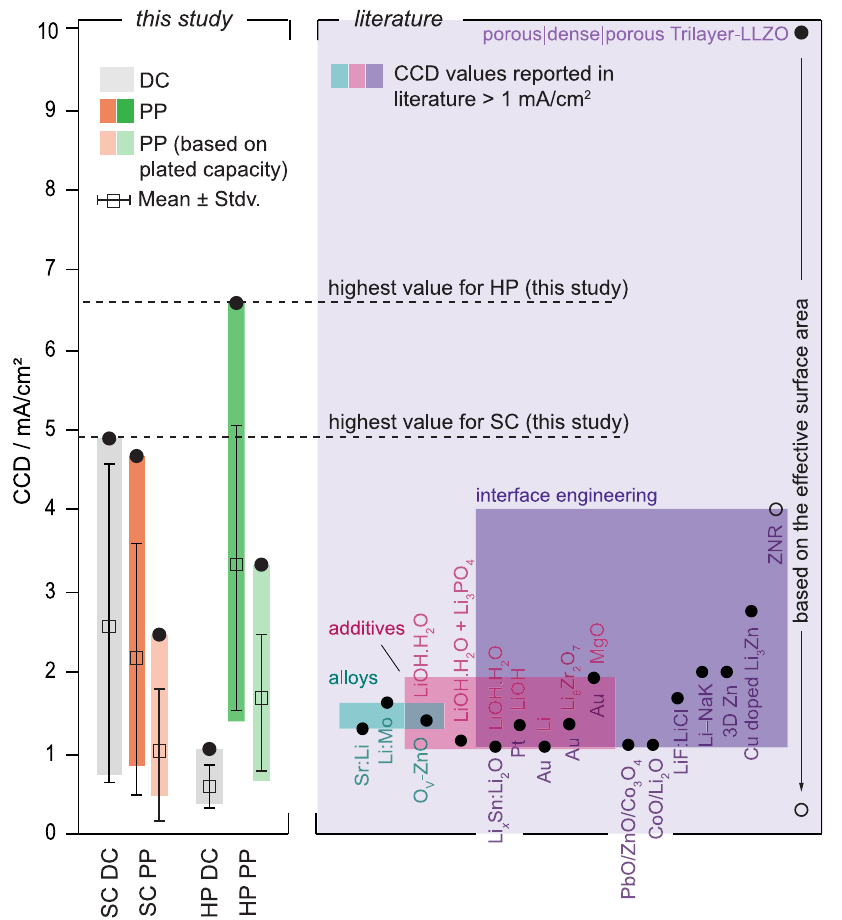
Fig. 2 | Analysis and comparison of the experimental electrochemical mea- surements. Rankingofthecriticalcurrentdensity(CCD)valuesachievedforsingle crystalline (SC) and hot-pressed polycrystalline (HP) samples during either direct currentapplication(DC;markedingray)orpulseplating(PP;markedinorangeand green for single crystalline and polycrystalline samples, respectively) operation. CCD values obtained during pulse plating are represented by black circular mar- kers, whereas effective CCD eff values, considering the time increase during the measurement compared to the values when direct current has been applied, are plotted as white rectangular markers. The violet section shows CCD values above 1mA/cm 2 reported in literature for different LLZO chemistries (excluding